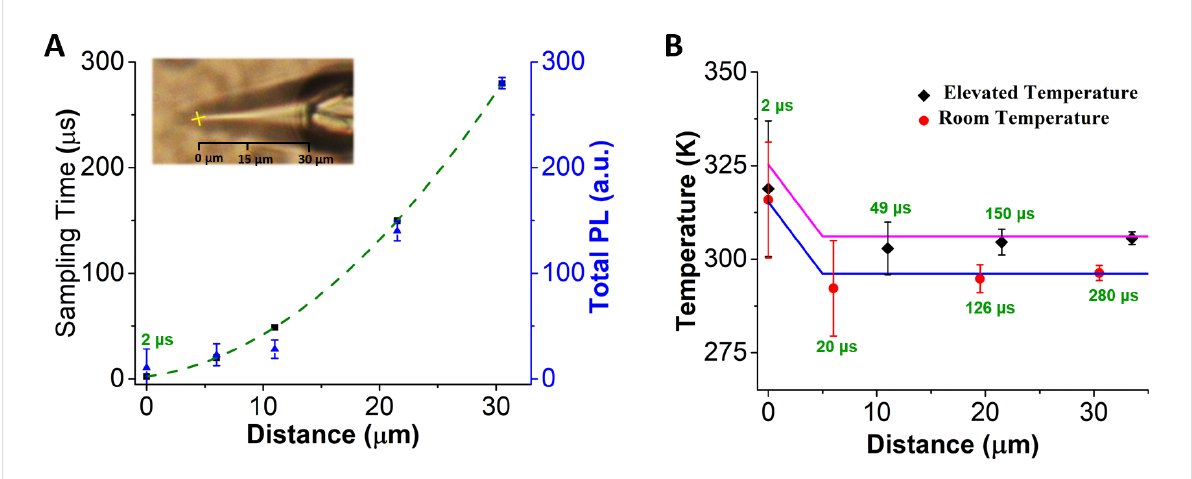
Figure 7: (A) Plot of sampling time and total photoluminescence intensity of UCNPs versus distance from the tip of a Taylor cone ( x tip = 0). Both sampling time and intensity follow an r 2 -dependence along the jet where r is the radius of the cross section perpendicular to x . Distance x and radius r are related by r = x tan θ where θ is the Taylor cone angle. The sampling time reduces to 2 μ s at the tip. (B) A plot of temperature calculated along the trajectory of a Taylor cone at room temperature (296 K) and at elevated temperature (306 K). The sampling time at a given distance is indicated in the